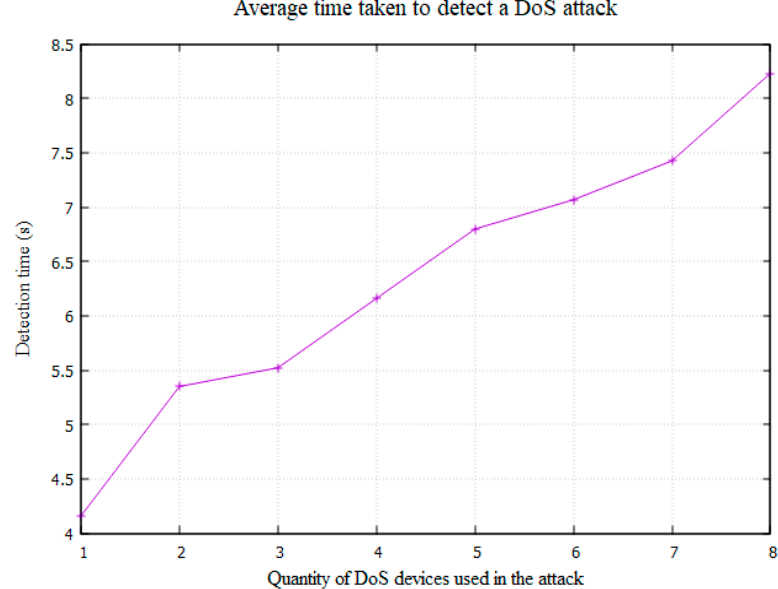
Figure 10. Average time taken to detect the DoS attack at each strength of attack.